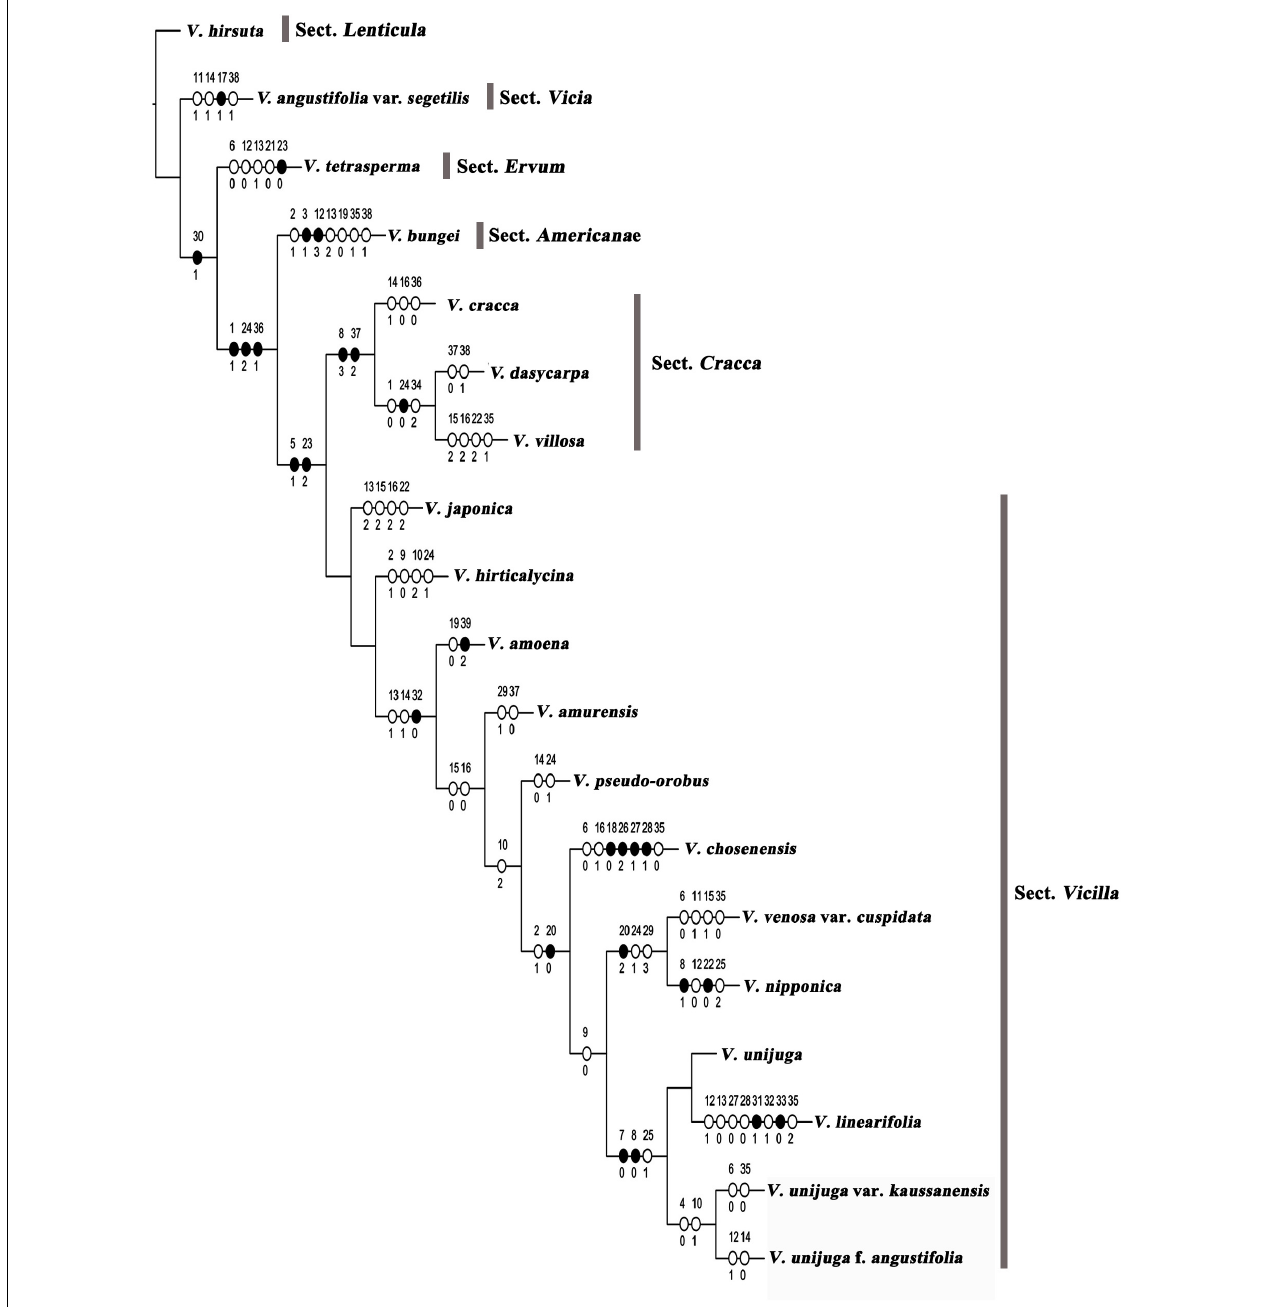
FIGURE 4 | Character support for phylogenetic positions of Vicia species. Strict consensus tree (length = 135 steps; CI = 0.48; RI = 0.56) showing the character state optimizations at each node of the cladogram, represented by circles. Non-homoplastic changes in character states are represented by black circles, and homoplastic changes are shown with white circles. The numbers above and below each circle represent the character and character state number, respectively. Matrix information on characters and character state numbers: (1) life form (0, annual or biannual; 1, perennial); (2) growth habit (0, climbing; 1, erect; 2, ascending); (3) tuber presence (0, absent; 1, present); (4) stem height [0, small (up to 40 cm); 1, high (over 40 cm)]; (5) stem form (0, slender; 1, rigid); (6) stem pubescence [0, glabrous; 1, sparse (epidermis visible); 2, dense (epidermis not visible)]; (7) leaflet pairs per leaf (0, one pair; 1, more than two pairs); (8) number of leaflets (0, 2; 1, 4–8; 2, 6–14; 3, 16–24); (9) leaflet size relative to leaf (0, same size; 1, larger at leaf base); 10, leaflet length (0, < 2.0 mm; 1, 20–40 mm; 2, > 40 mm); (11) leaflet width (0, < 10 mm; 1, 10–20 mm; 2, > 20 mm); (12) leaflet shape (0, elliptic; 1, lanceolate; 2, oblong; 3, obovate; 4, ovate); (13) leaflet apex (0, acuminate; 1, acute; 2, obtuse; 3, truncate); (14) leaflet base (0, cuneate; 1, obtuse); (15) leaflet adaxial hair density [0, glabrous; 1, sparse (epidermis visible); 2, dense (epidermis not visible)]; (16) leaflet abaxial hair density [0, glabrous; 1, sparse (epidermis visible); 2, dense (epidermis not visible)]; (17) stipule nectariferous spot (0, absent; 1, present); (18) stipules present (0, absent; 1, present); (19) stipule surface (0, smooth; 1, hairy); (20) tendrils (0, absent; 1, present; 2, on some leaves); (21) tendril